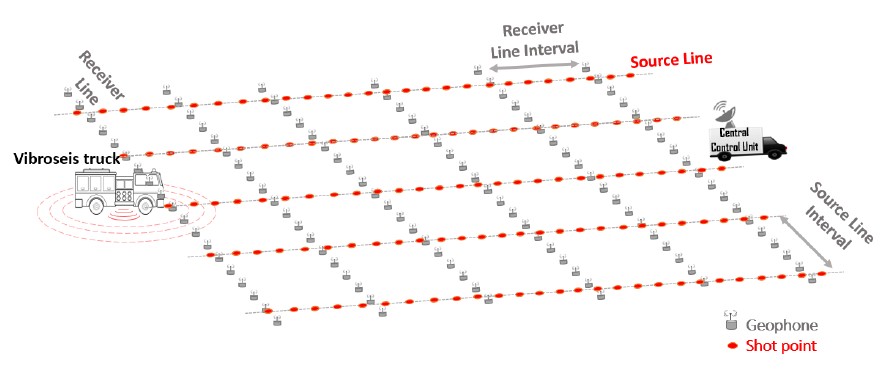
Figure 3. The wireless geophone network orthogonal